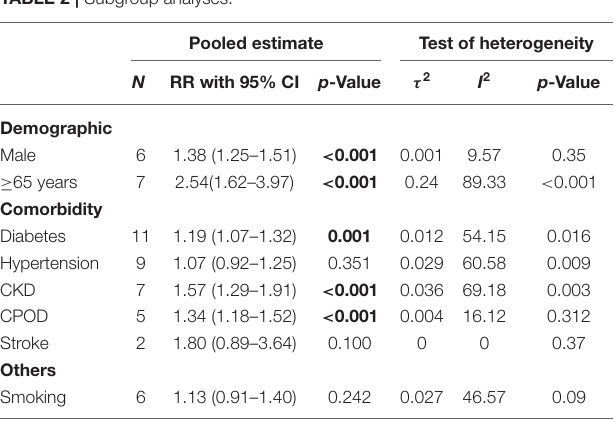
TABLE 2 | Subgroup